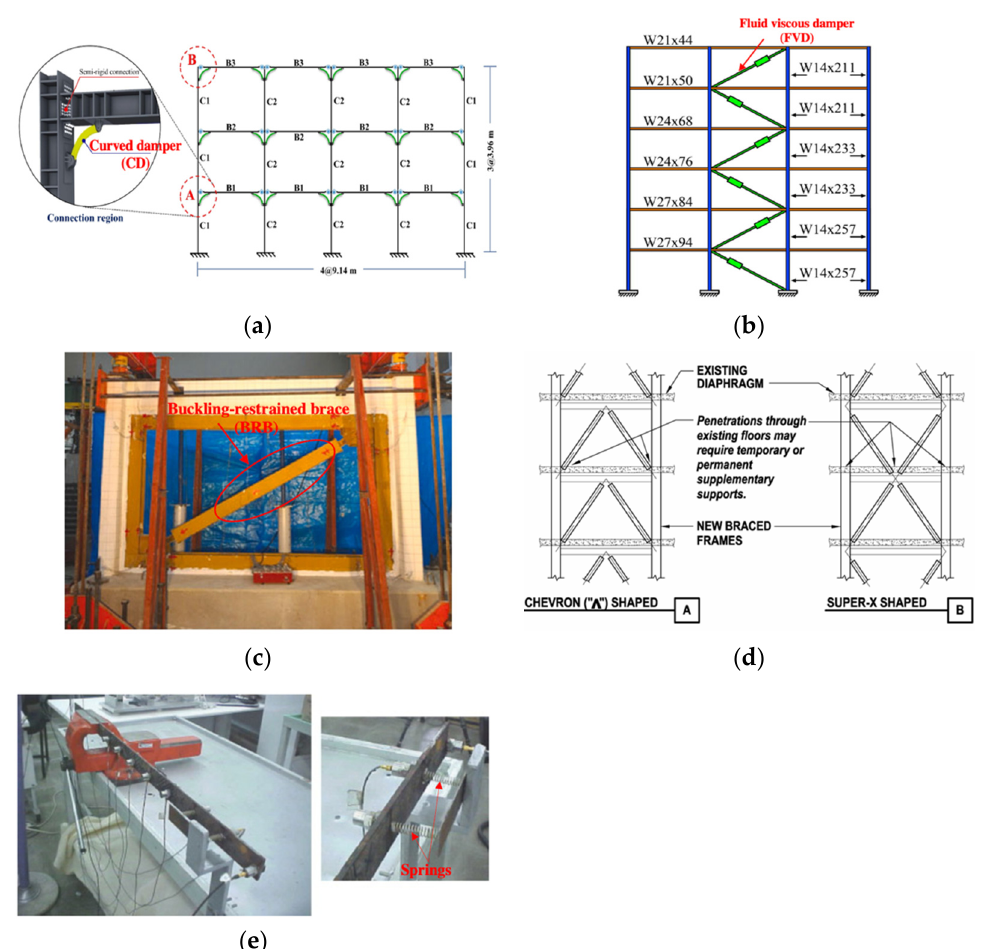
Figure 1. Additional components for stiffness modification: ( a ) curved damper [44]; ( b ) fluid viscous damper [45]; ( c ) buckling-restrained brace [46]; ( d ) steel diagonal brace [43]; ( e ) springs [48]. The proposed BMUA framework can be also applied along with repair/retrofitting techniques. In a schematic form, the post-repair condition (𝑴, 𝑲) (cid:3043)(cid:3042)(cid:3046)(cid:3047)(cid:2879)(cid:3019) is not fully unknown when (𝑴, 𝑲) (cid:3043)(cid:3042)(cid:3046)(cid:3047)(cid:2879)(cid:3019) are limitedly known due to structural damages or the coupling